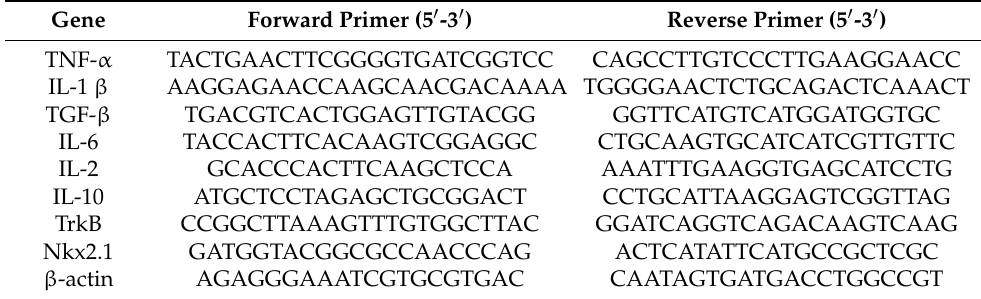
Table 2. Primers used in this